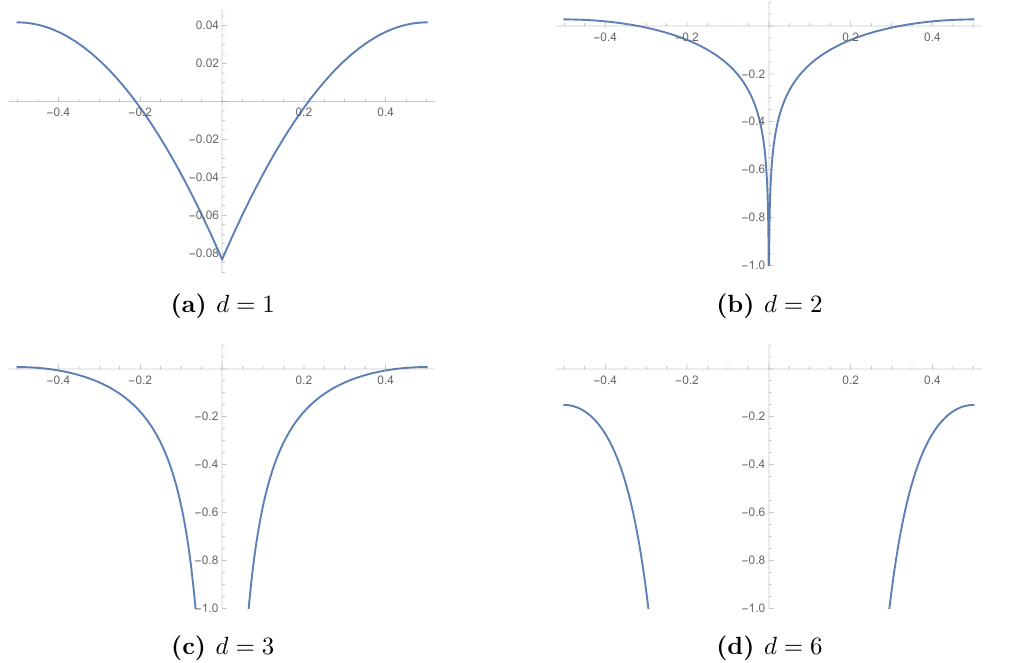
Figure 1. Green’s function (2 (cid:25)L ) d (cid:0) 2 G ( ~(cid:27) ) given in (3.6) for dimensions d = 1 ; 2 ; 3 ; 6, plotted